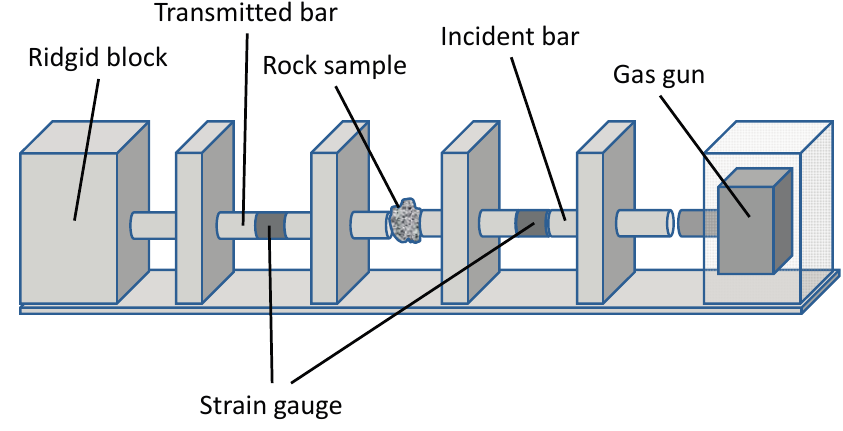
Figure 9. Split Hopkinson pressure